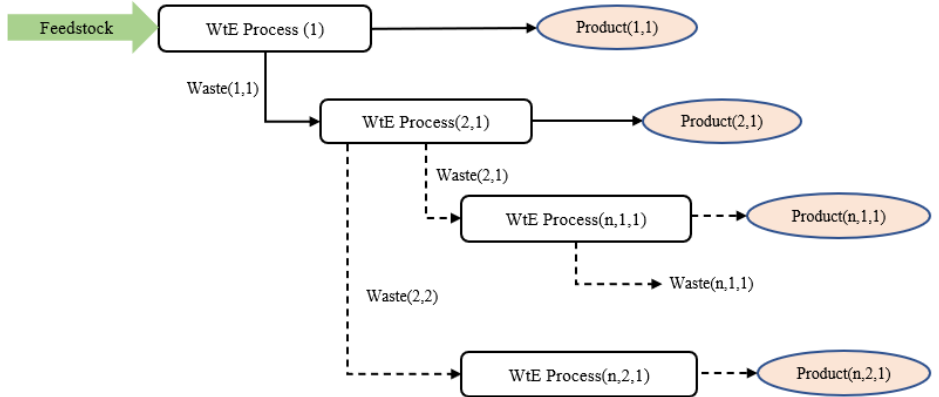
Figure 8. An illustration of biorefinery integration by waste, and/or byproducts. Table 2. Examples for biorefinery integration based on the exchange of waste/by-product .